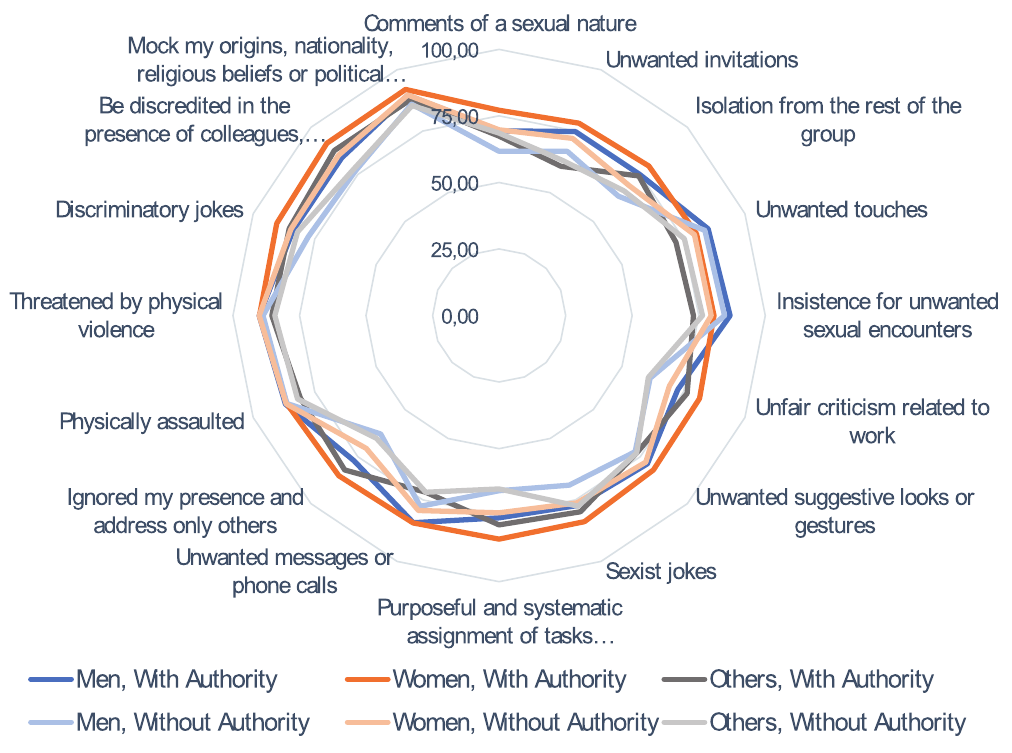
Figure 4. Percentage of students, professors, and staff who consider the above acts as moral harassment separated by gender and the authority of the harasser. Full text of the summarized items: ”Purposeful and systematic assignment of tasks inferior or superior to your competences”, ”Mock my origins, nationality, religious beliefs, or political beliefs”, and ”Be discredited in the presence of colleagues, superiors, or